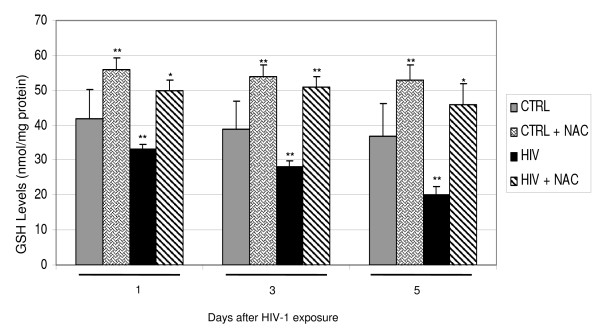
Effects of NAC on GSH value. In control experiments GSH level was expressed as nmol/mg protein and * p < 0.01; ** p < 0.05; *** p < 0.001 when compared with control; §p < 0.01; §§§ p < 0.001 when compared with HIV. F: 13.42, 18.60, 11.78, respectively at day 1, 3, 5. The data represent mean + SEM %.